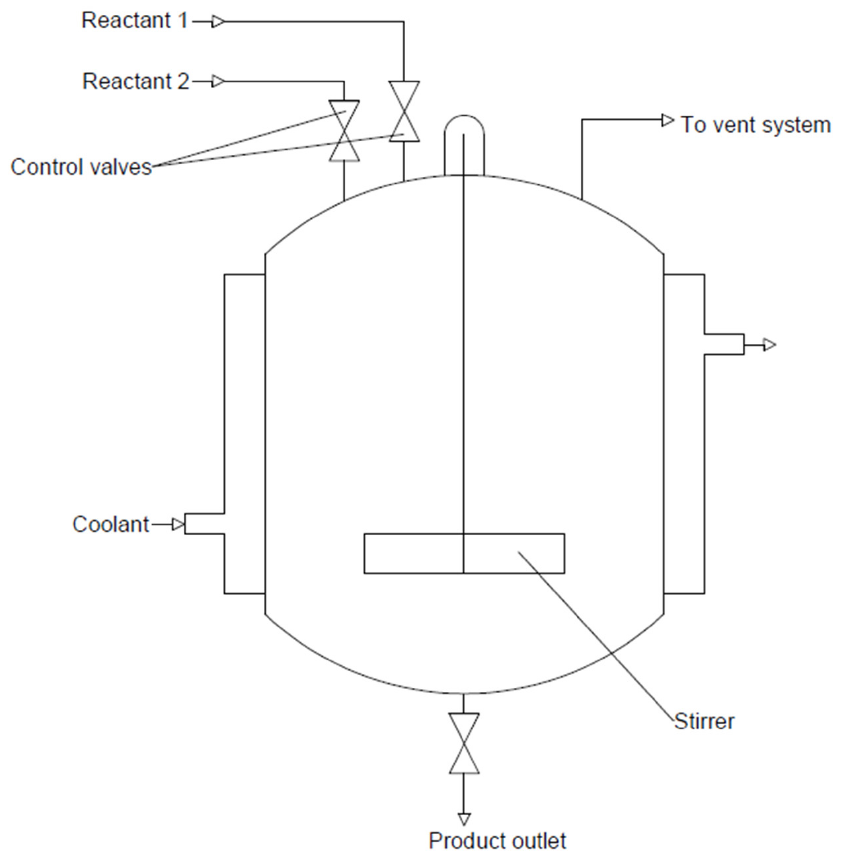
Figure 15. Scheme of a microreactor. Reproduced with permission [126].